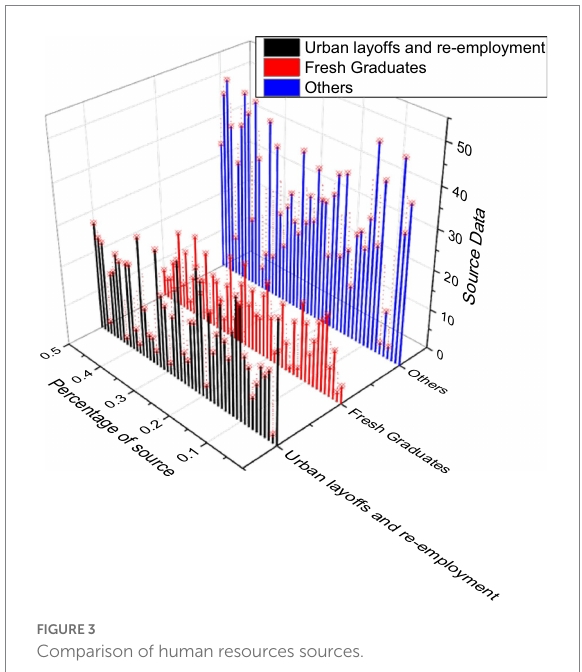
FIGURE 3 Comparison of human resources